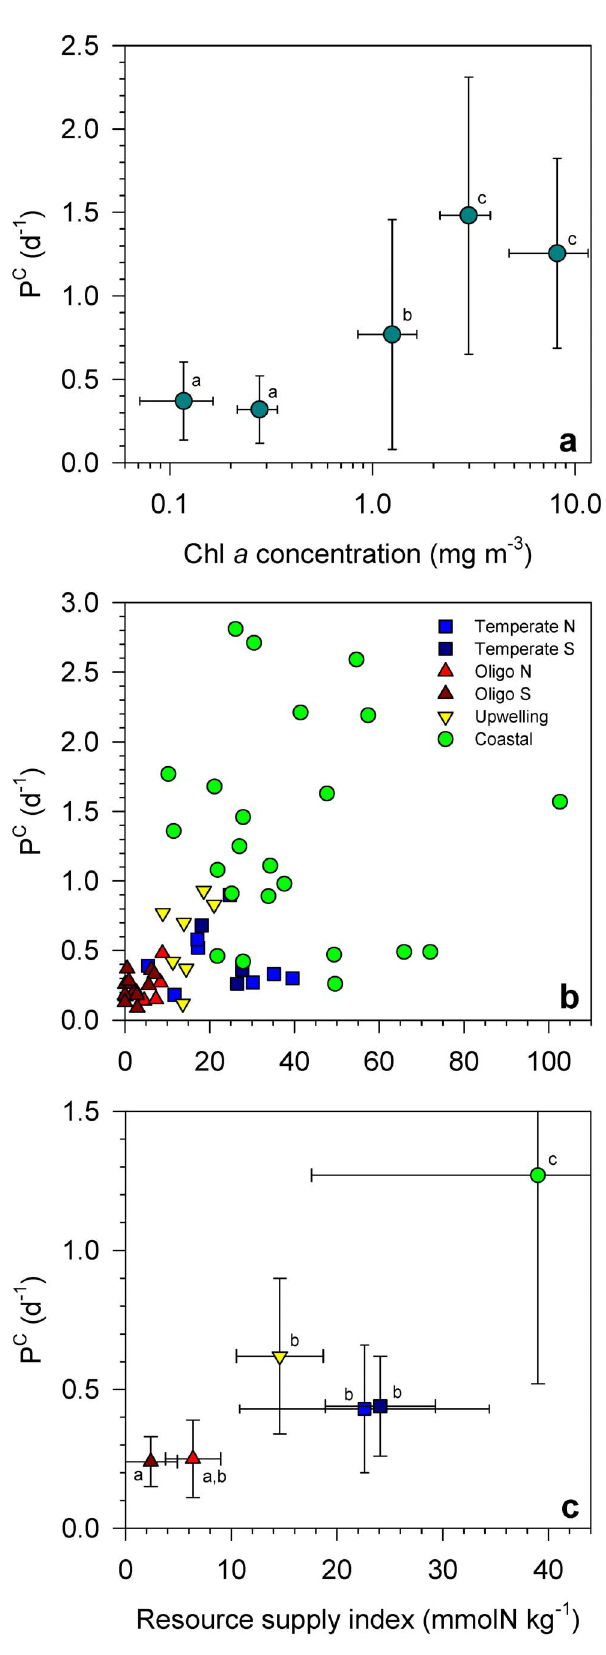
Figure 3. Resources and phytoplankton growth. Carbon-specific production rate (P C ) as a function of (a) chlorophyll a concentration (chl a ) and (b, c) resource supply index ( RSI ). P C data in (a) were grouped into the following chl a ranges: 0–0.2, 0.2–0.5, 0.5–2, 2–5 and . 5 mg m 2 3 . Bars indicate 6 1 standard deviation. Data groups labelled with different letters in (a) and (c) have significantly different P C values (Mann-Whitney U test, p , 0.05). The units of RSI derive from the division of nitrate concentration by seawater density. Note that RSI is not a nutrient concentration, but reflects both nutrient and light availability (see Material and Methods for